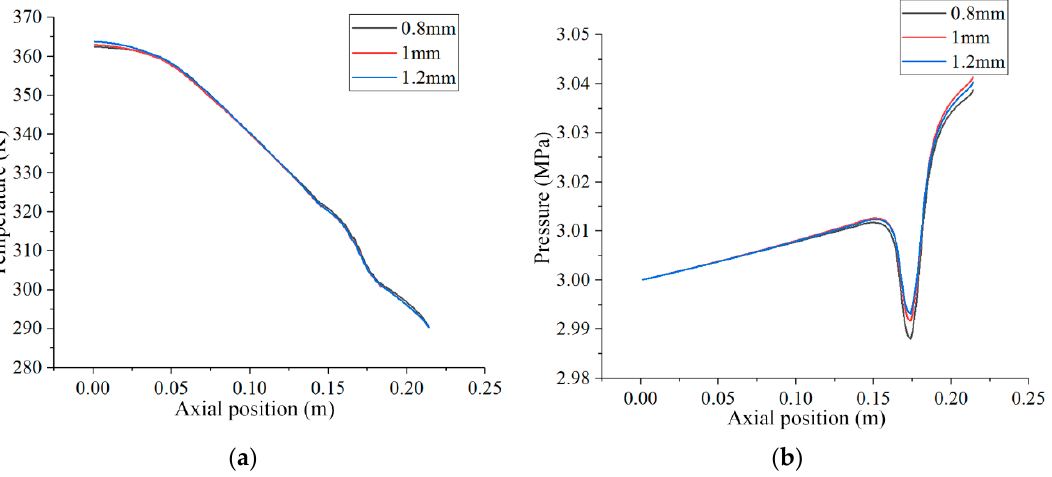
Figure 26. Temperature and pressure along the coolant with different inner wall thicknesses. ( a ) Temperature along the course of coolant; ( b ) pressure along the course of coolant.